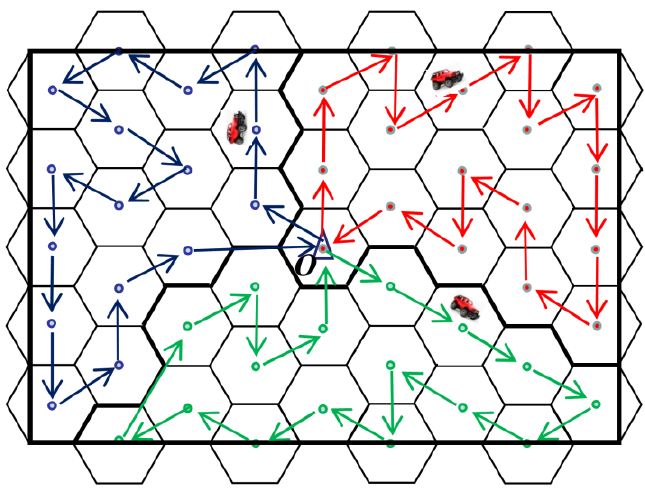
Figure 14. The shortest moving path of MDC in each region.